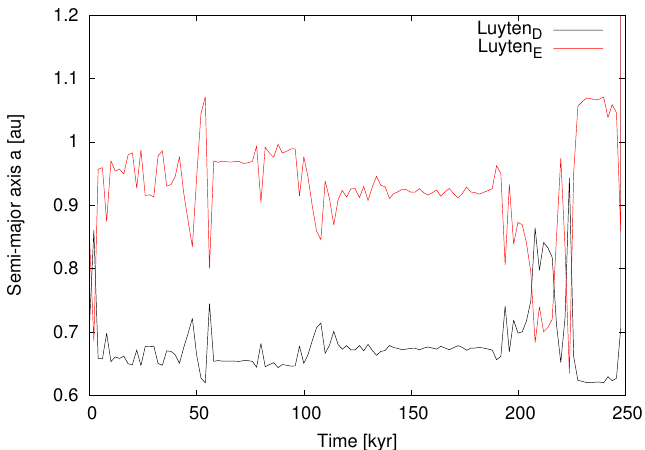
Figure 7. Nominal case ( e D = 0.17, e E = 0.03): Time evolution of the two outer planets over 10 Myr. This configuration is also unstable, resulting in a collision.